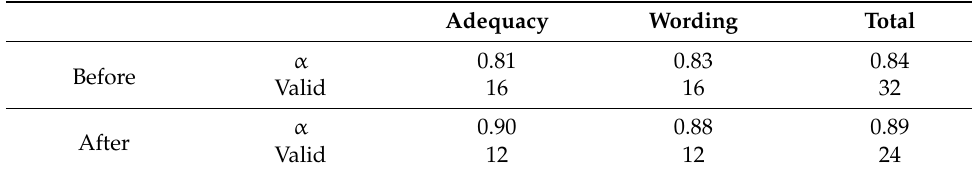
Table 7. Reliability analysis of the NAPOA